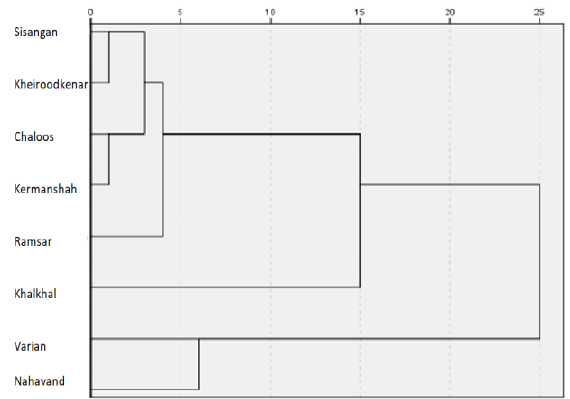
Fig. 2. Clustering of violet populations based on morphological